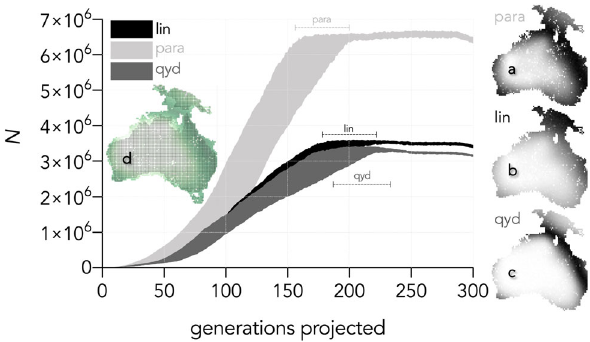
Fig. 3 Projected population size according to three assumed relationships between human carrying capacity ( K ) and net primary production ( P p ). In all three curves, we applied top-ranked scenario settings (50-ka entry at the southern entry-point), but altered the underlying carrying capacity – net primary production relationship. Shaded areas represent 95% con fi dence intervals based on 100 stochastic simulations. The best-supported relationship was for the rotated parabolic ( a . para; see also Supplementary Fig. 2), followed by the linear ( b . lin) and then the quadratic yield density ( c . qyd). The rotated parabolic resulted in a fi nal population size of 6.31 – 6.51 million people at 300 generations, or an average population density of 0.55 – 0.57 people km − 2 . The linear model projected a total continental population of 3.37 – 3.46 million inhabitants at 300 generations (an average population density of 0.29 – 0.30 people km − 2 over the entire continent), and the quadratic yield density projected a population of considered high compared with existing archaeological data (see ‘ Discussion ’ ), but provide an indication and trends of the populations during the initial peopling of the continent. Inset d shows the extent of Sahul overlaid with the modern grid for Australian and New Guinea. This reveals that 27.5% of the population estimate is attributed to now-drowned parts of the continental shelf. Further, the horizontal bars indicate the range of generations required to reach saturation of Sahul for each K – P p relationship. The maps on the right show the relative population distribution at 300 generations for a single iteration following the three different K – P p relationships. See ‘ Methods ’ (cellular-automaton framework) for the source of the map extent for